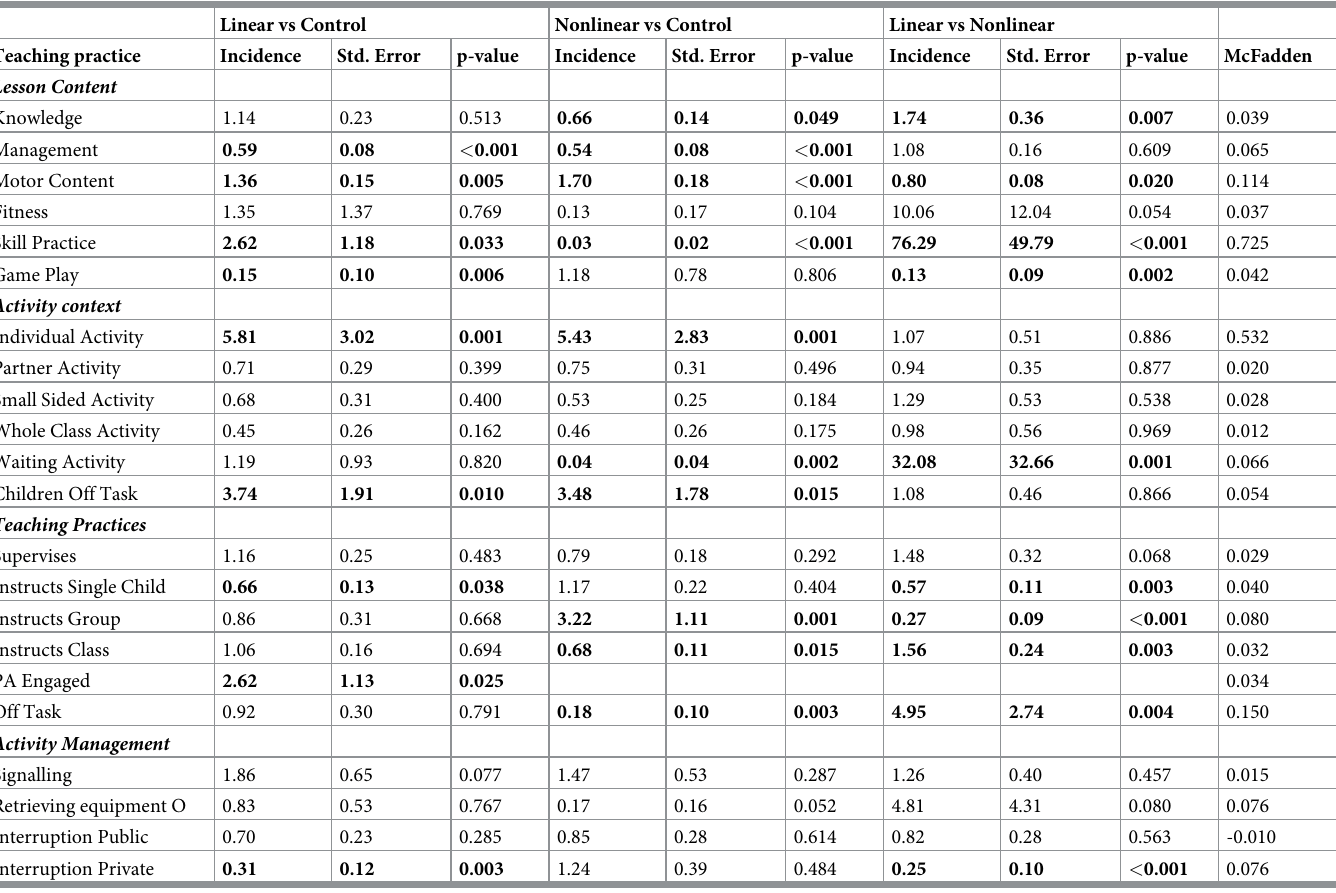
Table 7. Difference in teaching practices between the interventions and control